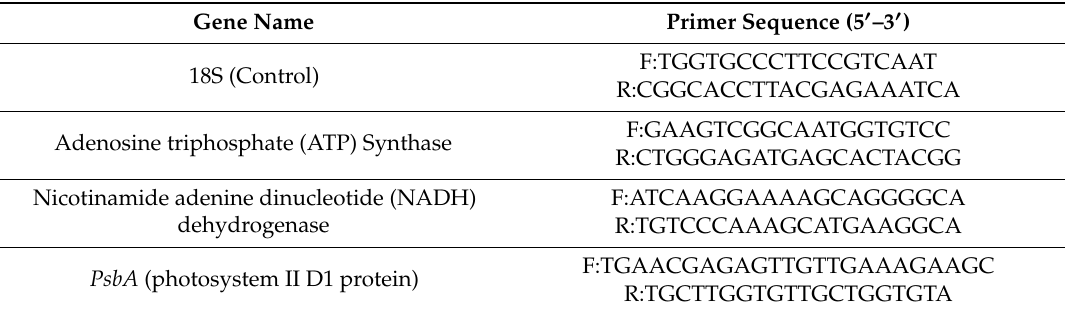
Table 1. Primer used in quantitative reverse transcription polymerase chain reaction (RT-qPCR) analysis. Gene